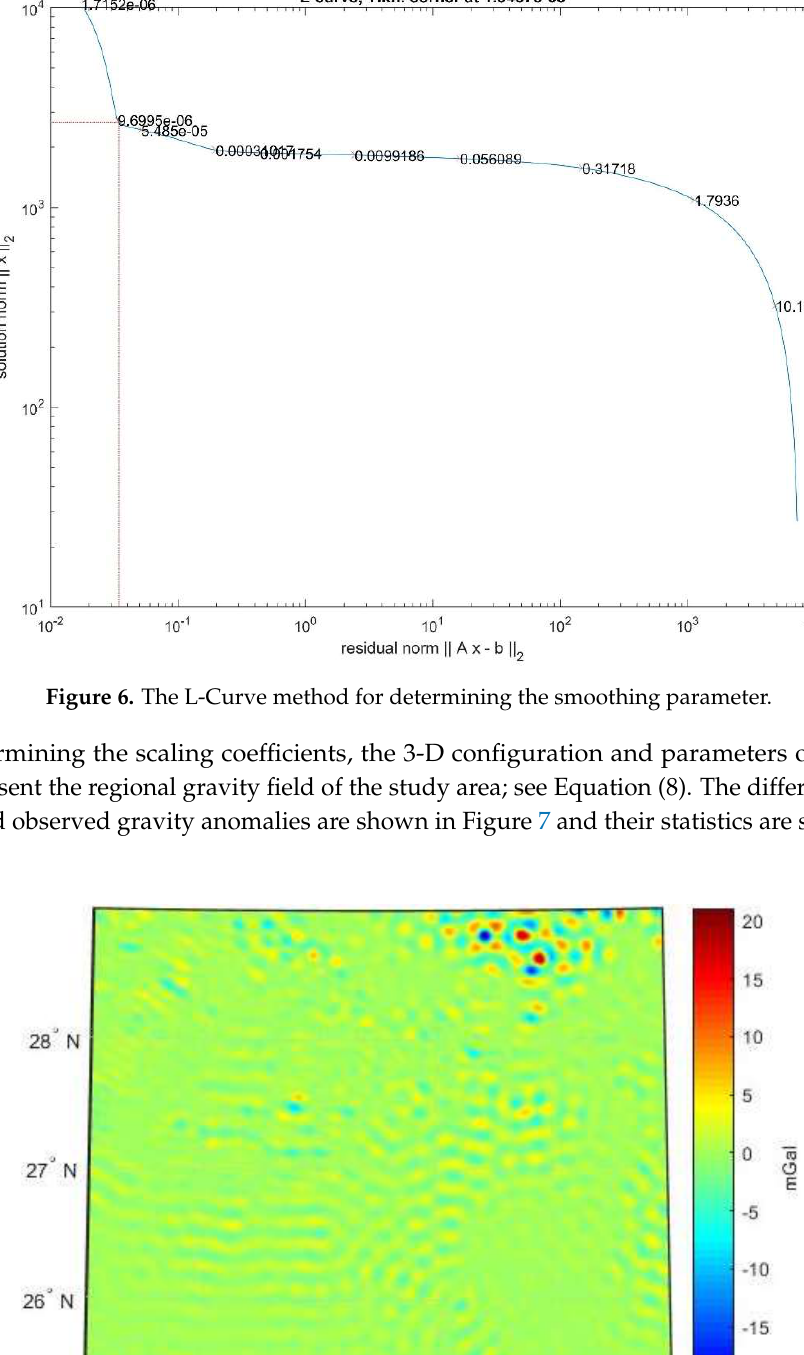
Figure 7. The discrepancies between predicted and observed gravity anomalies (mGal).